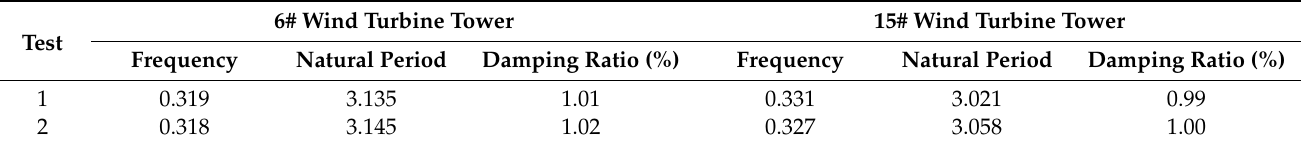
Table 2. Statistics of identified natural frequencies and damping ratios.